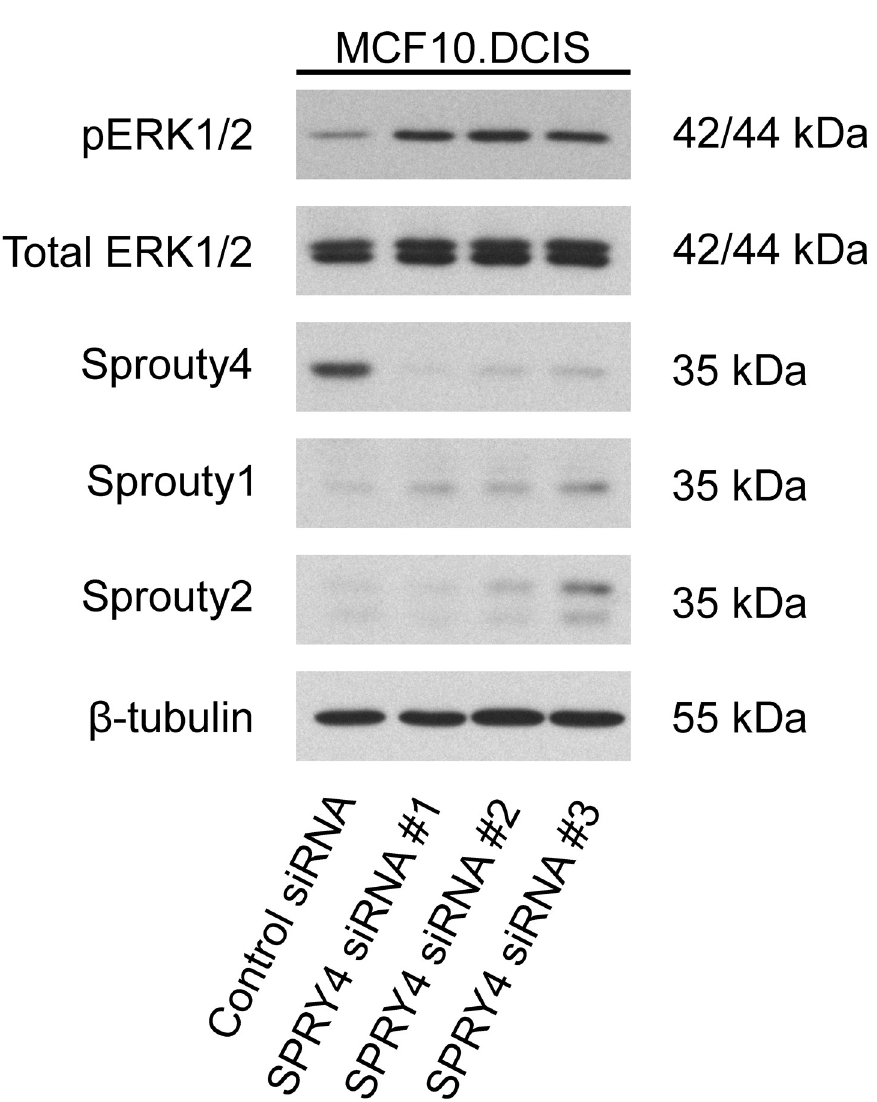
Fig 10. Transient knockdown of Sprouty4 in MCF10.DCIS cells enhances ERK/MAPK signaling. MCF10.DCIS cells were grown in 2D culture, then transfected with either a non-targeting control siRNA or one of three non- overlapping siRNA constructs targeting SPRY4 for 48 hours. Membranes were immunoblotted for phosphorylated ERK1/2 (pERK1/2), total ERK1/2, Sprouty4, Sprouty1, Sprouty2, and β -tubulin. Expression levels are representative of three independent